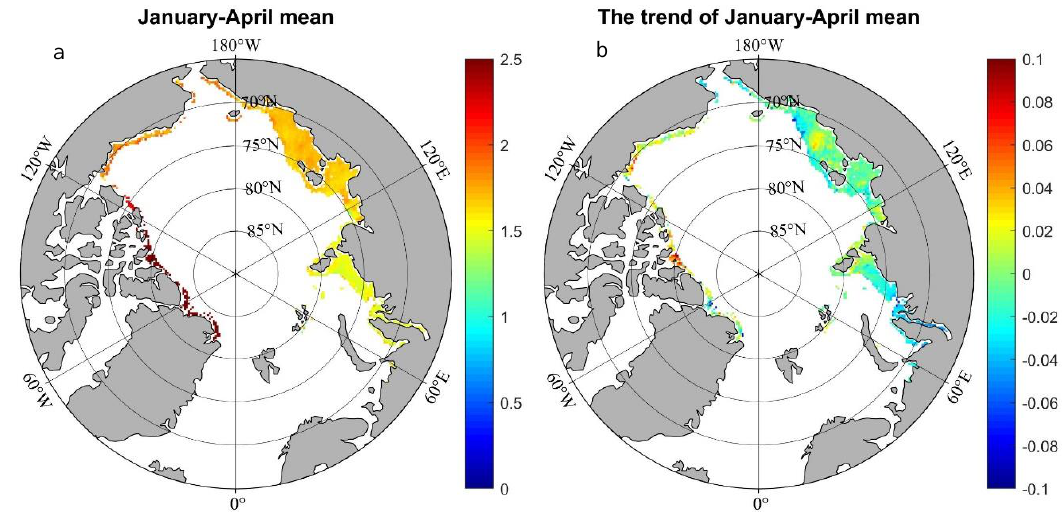
Figure 8. ( a ) multiyear mean landfast ice thickness (m) for January–April from 2011 to 2018 and ( b ) its trend (m / yr). These data are derived from the NSIDC CryoSat-2 products. The edge of landfast ice was defined by the corresponding 10% of occurrence in Figure 3.